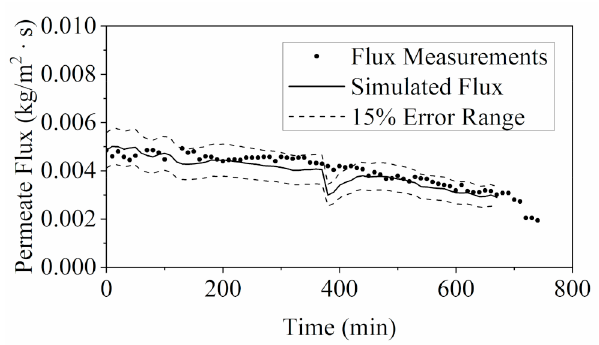
Figure 9. Validation of MD model via comparing simulated permeate flux with flux measurements taken during the experiment at 60 ◦